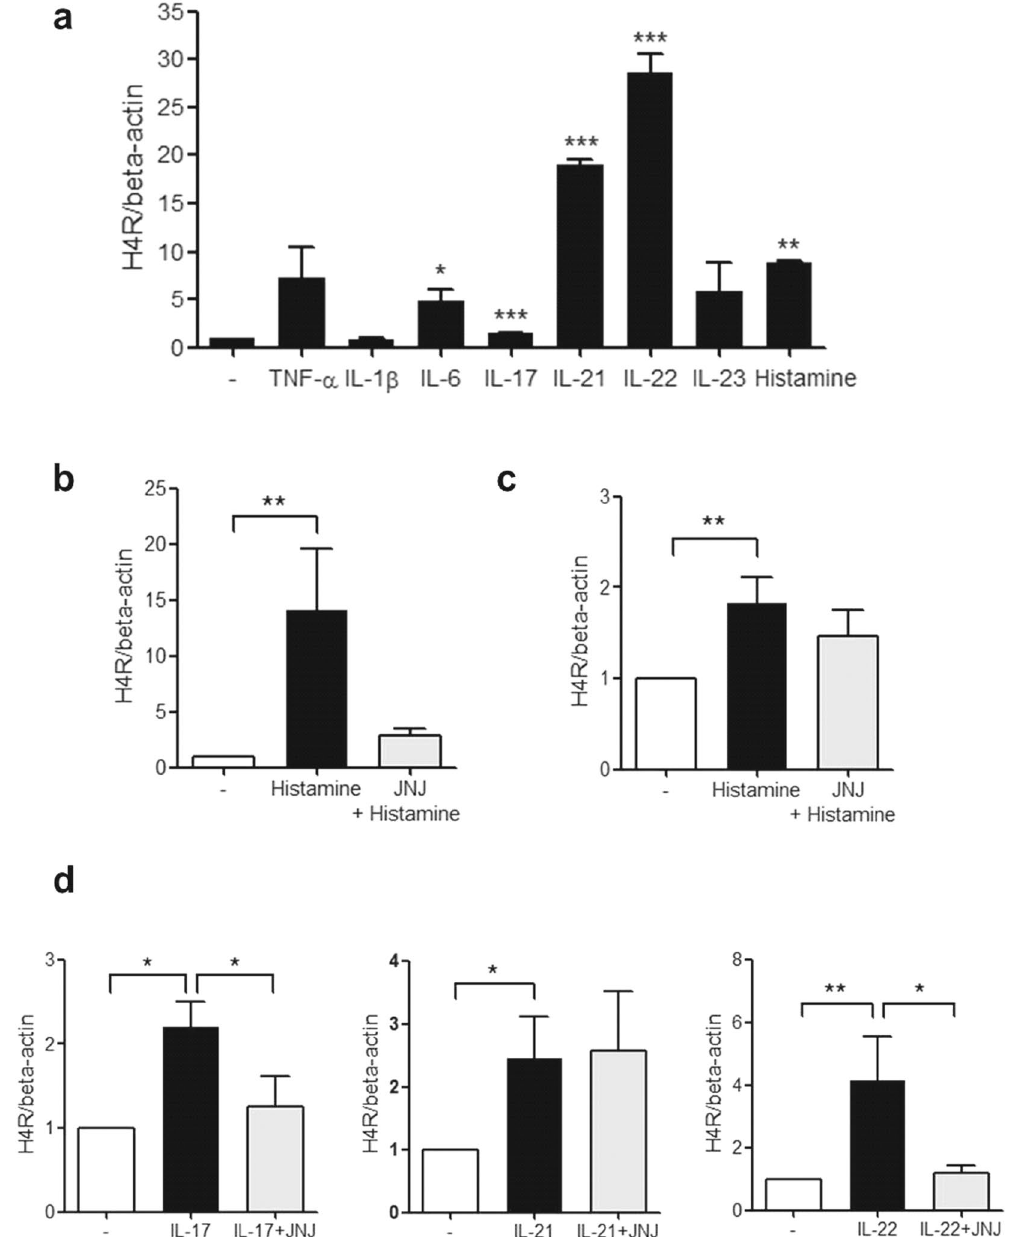
Figure 3. The expression of H4R mRNA induced by histamine and inflammatory cytokines. ( a ) After PB monocytes were cultured with 20 ng/ml of TNF- α , IL-1 β , IL-6, IL-17, IL-21, IL-22, IL-23 and 10 − 5 M of histamine for 16 h, the expression of H4R mRNA was determined by real-time PCR. ( b ) After PB CD14 + monocytes from 3 RA patients were cultured with 10 − 5 M of histamine and 10 μ M of JNJ7777120, a selective H4R antagonist, for 16 h, the expression of H4R mRNA was determined by real-time PCR. ( c ) After SF CD14 + monocytes from 3 RA patients were cultured with 10 − 5 M of histamine and 10 μ M of JNJ7777120 for 16 h, the expression of H4R mRNA was determined by real-time PCR. ( d ) After PB monocytes from 3 RA patients were cultured with IL-17, IL-21, IL-22 and 10 μ M of JNJ7777120 for 16 h, the expression of H4R mRNA was determined by real-time PCR. Data were normalized to beta-actin and reported in relative expression units. The data represent the mean ± SEM of three independent experiments. * P < 0.05, ** P < 0.01 and *** P < 0.001. H4R; histamine H4 receptor, JNJ;